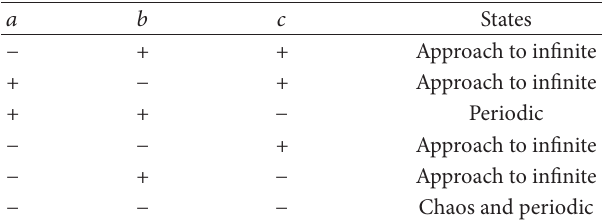
Table 1: Dynamic behaviors of historical Lorentz system for different signs of parameters.